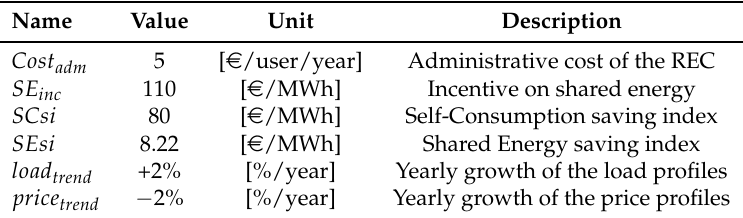
Table 3. Economical data.